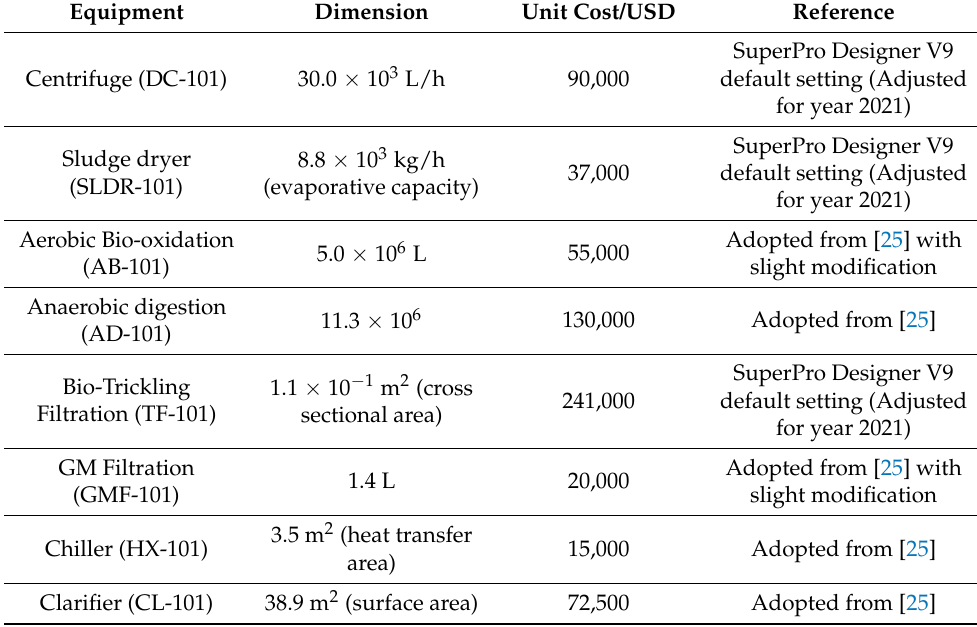
Table A5. Major equipment cost of IAAB for the treatment of POME and biogas production. Note: Other equipment not specified is claimed to be as per SuperPro Designer V9 default